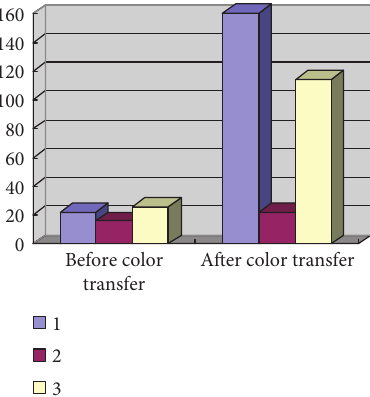
Figure 6: The mean value of tones and border overlap ratio in adjacent